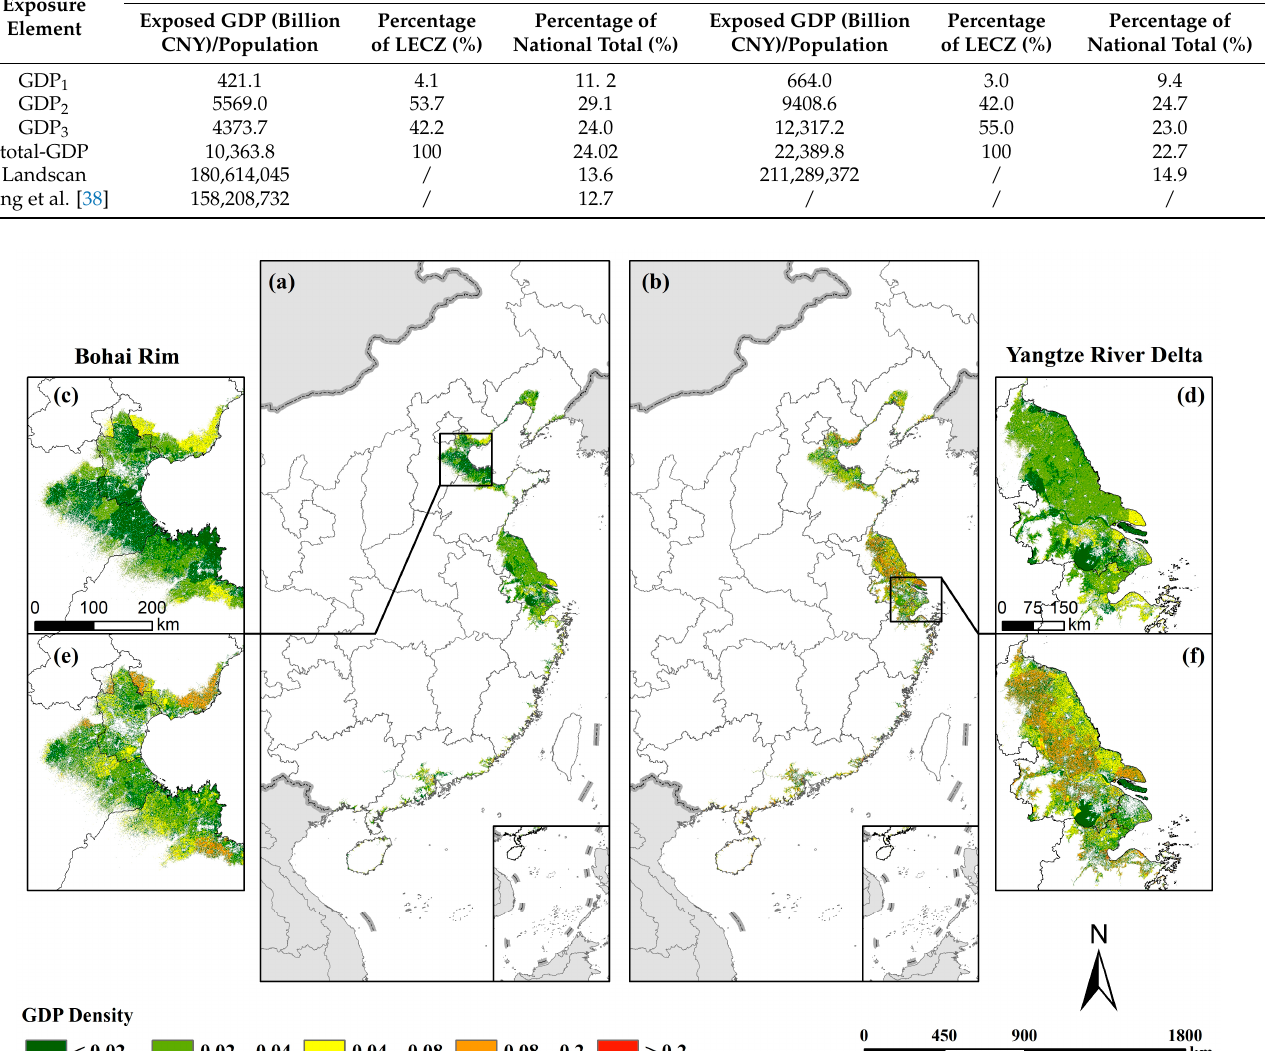
Figure 5. A 100 m gridded GDP 1 map of China’s LECZ in 2010 ( a , c , d ) and 2019 ( b , e , f ) (unit: million CNY/ha).